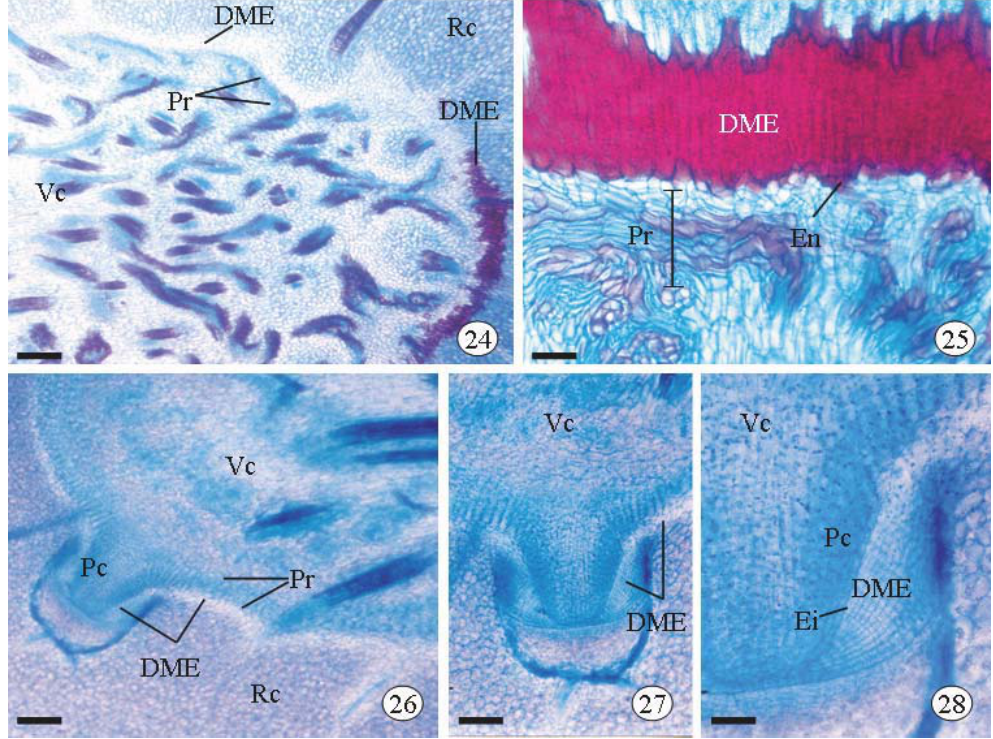
Fig. 24-28 – Cephalostemon riedelianus . Transverse sections of the rhizome, one showing in Fig. 24 the DME (Derivatives of the Meristematic Endodermis) layers presenting a translucid aspect when not thickened. Fig. 25 – Note the totally thickened DME layers, the inner cortex of the rhizome and the pericycle (Pr) comprising the generating layer of vascular tissues. Fig. 26 – Note the presence of an adventious root and the continuity between the DME of the root and the rhizome, better visualized in Fig. 27. Fig. 28 – Very distinct layers of cells that comprise the DME. Pc – procambium. Rc – rhizome cortex. Vc – vascular cylinder. The bars correspond respectively to: 600 µ m, 100 µ m, 400 µ m, 200 µ m and 100 µ